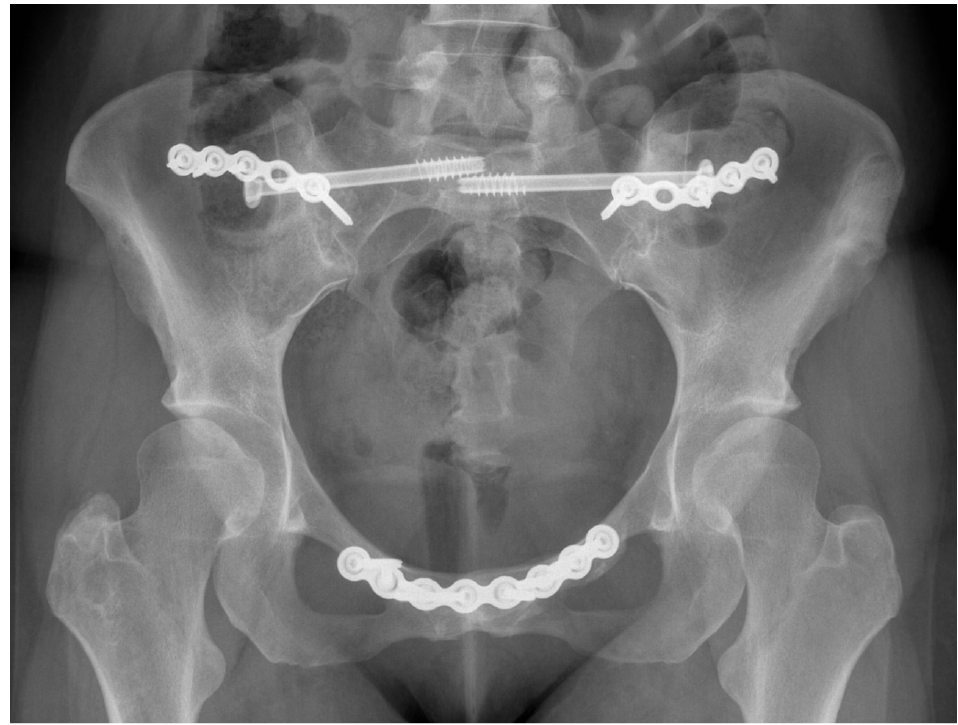
Figure 5. Anteroposterior pelvic radiograph of a 30-year-old female diagnosed with Ehlers-Danlos Syndrome demonstrating fusion of pubic symphysis and both sacroiliac joints (anterior plating, bone grafting and sacroiliac screw insertion).